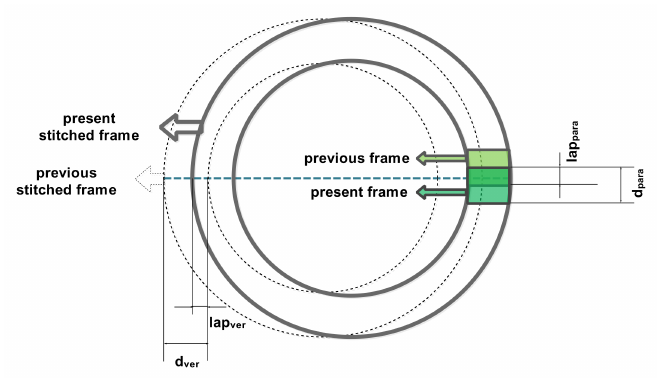
Figure 3. A diagram of the overlap between